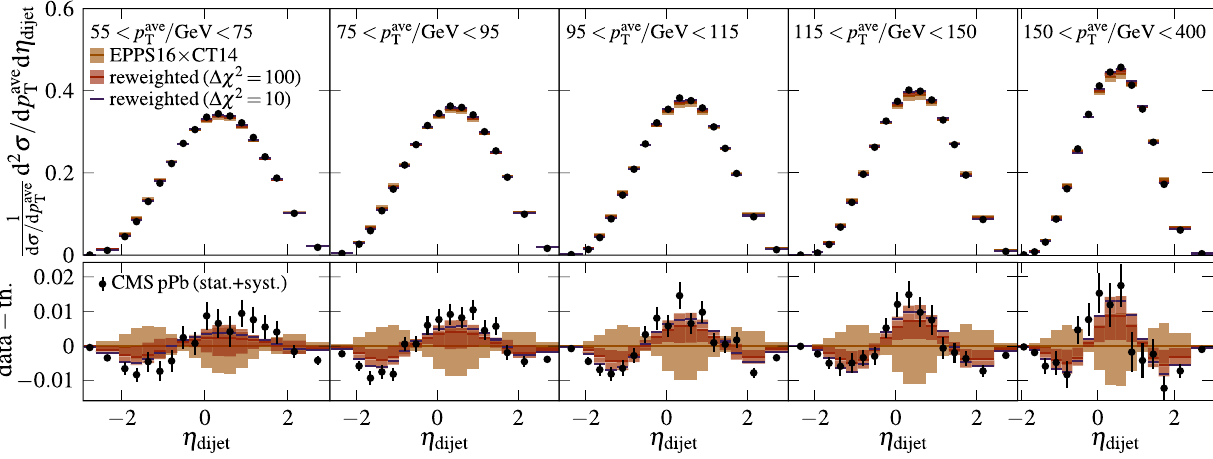
Fig. 8 As Fig. 4, but now with pPb data and with EPPS16 nuclear modifications imposed on the original and reweighted CT14 PDFs. Only uncertainties from the free-proton PDFs are shown